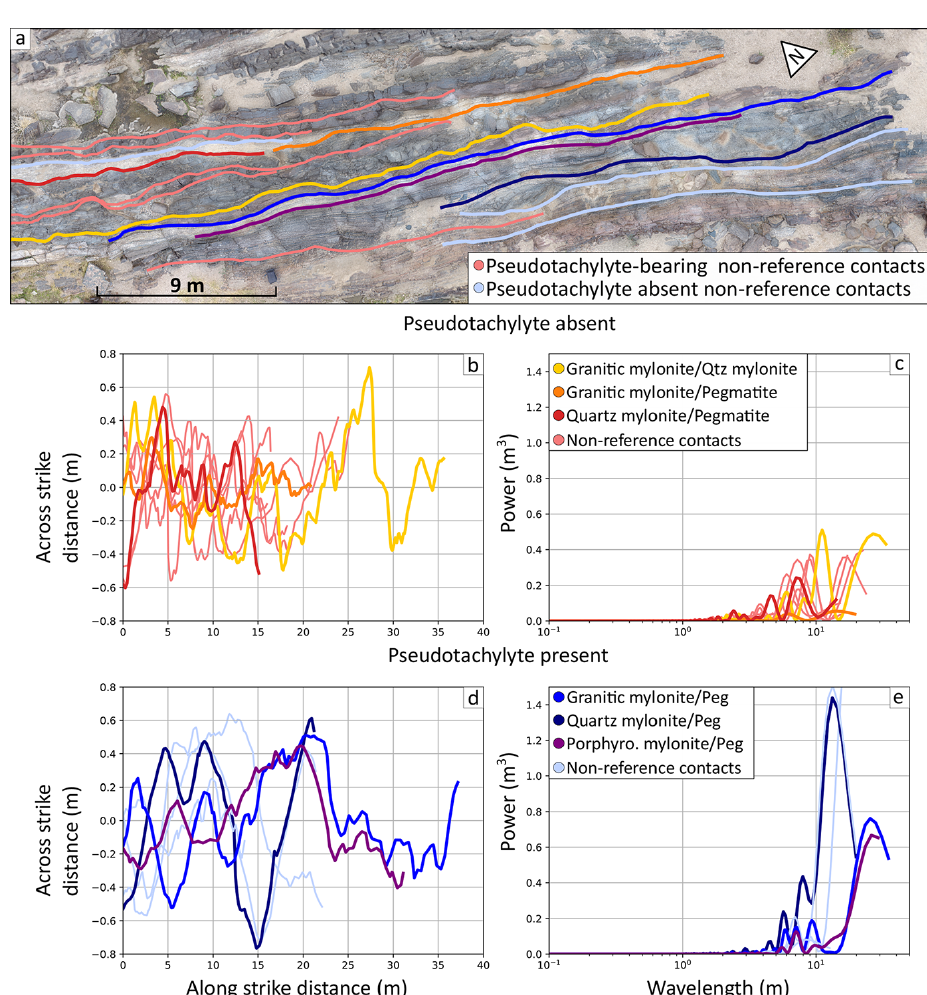
Figure 7. Mylonite layer interface maps. (a) Drone image with contact traces delineated, cool colors have pseudotachylyte and warm colors have no pseudotachylyte. Reference traces of similar wall rock layer thickness are shown in bright colors (see legend for plots) and other interfaces which are not controlled for layer thickness appear in pale colors. Top row of plots shows data for pseudotachylyte-bearing contacts (b,c) , and bottom row shows pseudotachylyte-absent contacts (d,e ). (b,d) Detrended profiles. (c,e) FFT for same contact traces highlights the wavelengths of increased power (m 3